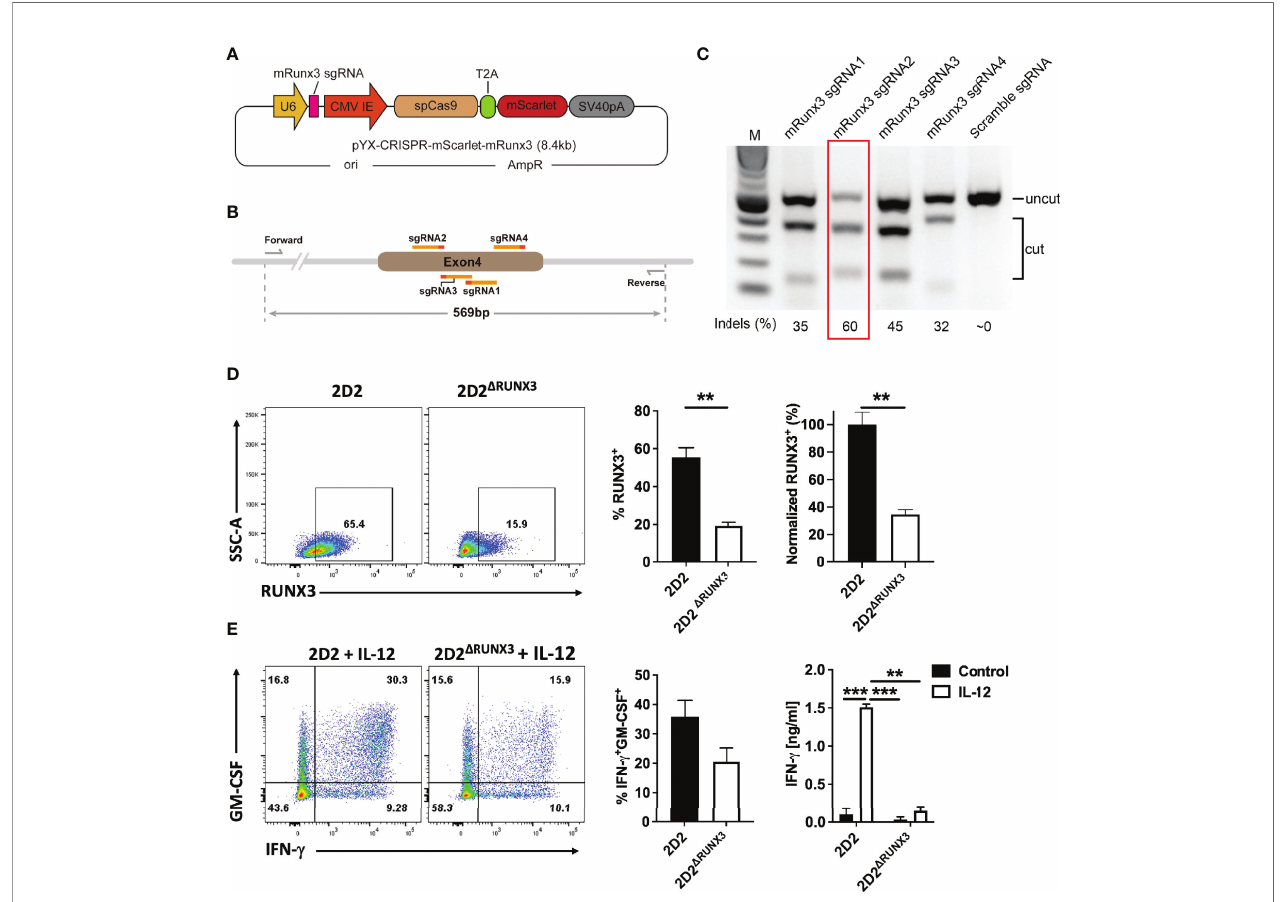
FIGURE 3 | ThGM cells require RUNX3 for their plasticity toward Th1-like phenotype. (A) Schematic showing structure of plasmid that carries mRunx3 sgRNA, Cas9, and mScarlet under CMV promoter. (B) Schematic showing targets of sgRNAs and detection primers on the genomic DNA of mRunx3. (C) N2A-Cas9 cell line was transfected with each mRunx3 sgRNA expressing plasmids; the ef fi ciency of knockouts was analyzed by T7E1 assay. (D) RUNX3 expression in ThGM cells was knocked out using CRISPR/Cas9 and remaining levels of RUNX3 in ThGM D RUNX3 cells were determined by fl ow cytometry. (E) ThGM and ThGM D RUNX3 cells were cultured with IL- 12 in the second stimulation and IFN- g concentration in cell culture supernatants was measured by ELISA. These experiments were conducted three times with similar outcomes. Data shown are mean ± SEM. P-values were calculated using unpaired Student ’ s t-test with Bonferroni ’ s correction; **p < 0.01, ***p <